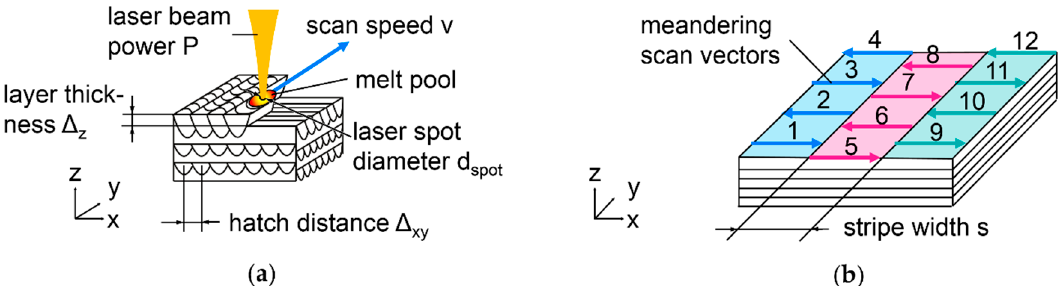
Figure 4. LBM parameters and scan strategies; ( a ) alternating meander scanning with opposite direction of neighboring scan vectors and 90° rotation around Z-axis each layer; ( b ) striped scanning. LBM parameters for establishment of initial situation in Section 3.2 are v = 650 mm/s and Δ xy = 25 µm. Alternating meanders are scanned, with double exposure of each layer.